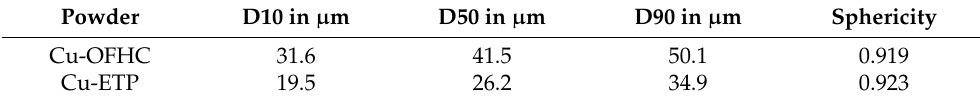
Figure 4. Particle size distribution of Cu-OFHC and Cu-ETP measured with the CAMSIZER X2. Table 1. Main characteristics of particle size distribution of Cu-OFHC and Cu-ETP.